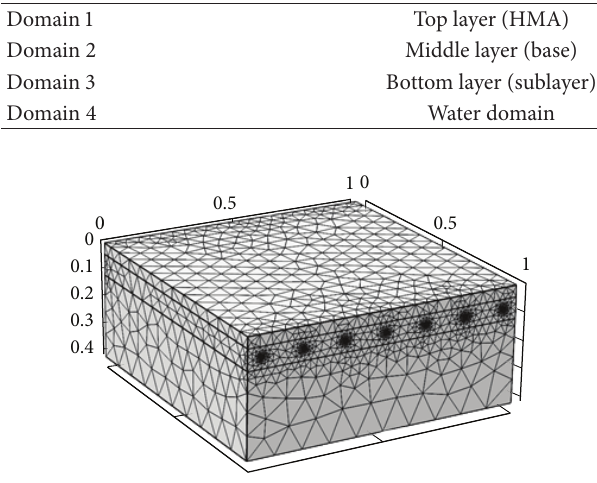
Figure 6: Meshed model.